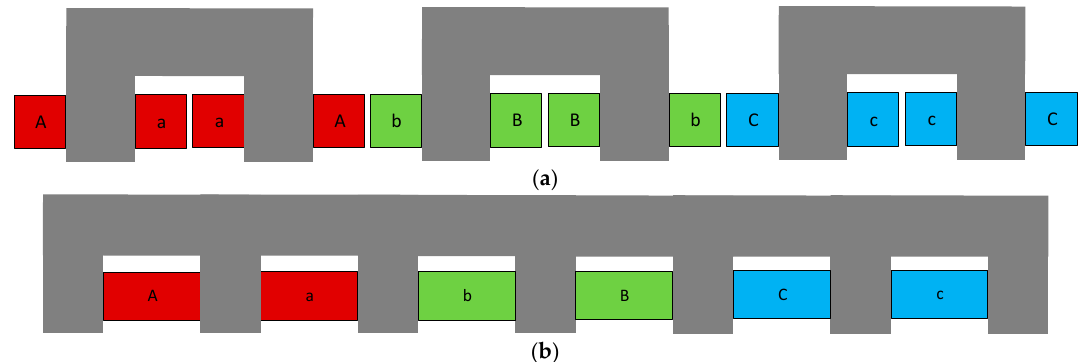
Figure 5. Segmented stator yoke for double layer winding ( a ); and, continuous yoke for single layer winding ( b ).